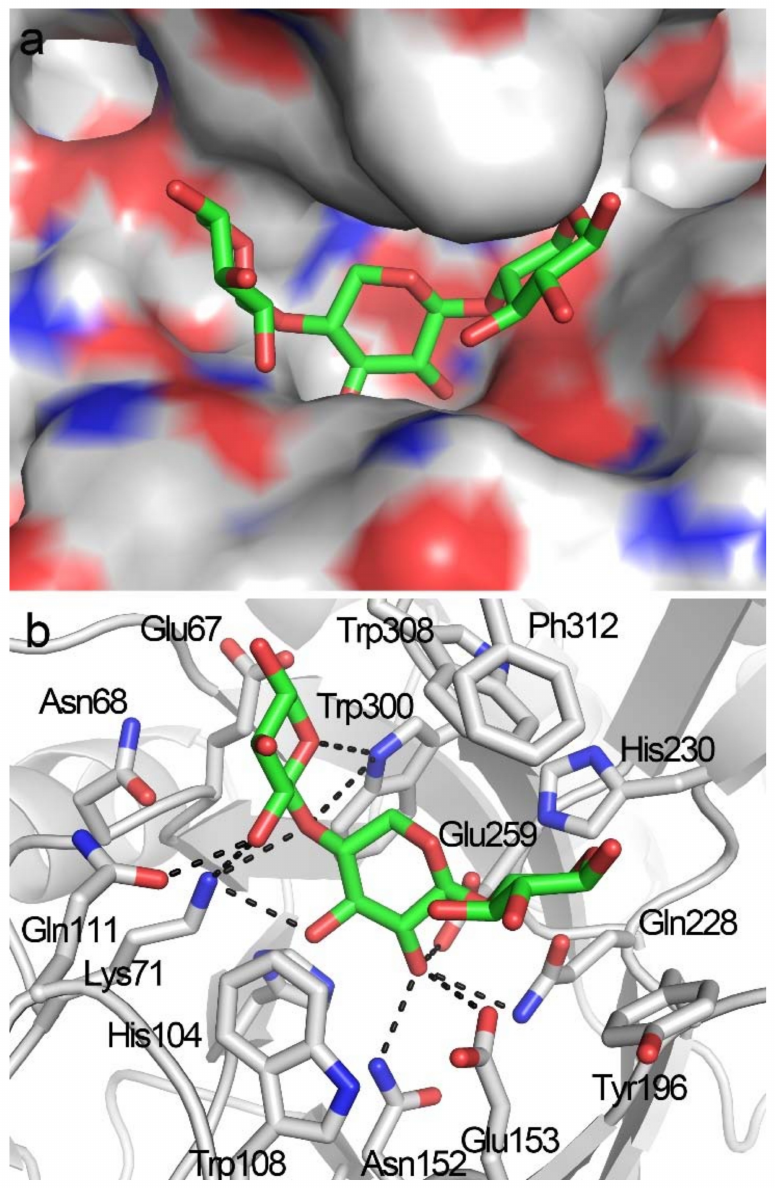
Figure 4. Docking structure of TmxB in complex with X3. ( a ) Docking conformations of X3 in the active-site cleft TmxB. ( b ) Interaction details between TmxB and X3 in the docking structure. The putative hydrogen bonds are indicated by black dashes. The carbon atoms of amino acids and X3 are shown in gray and green,